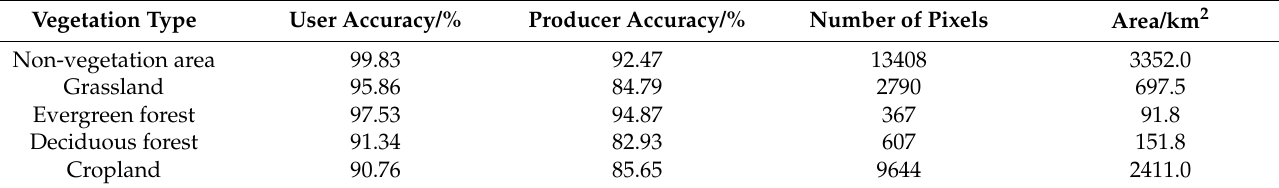
Table A3. The accuracy of vegetation